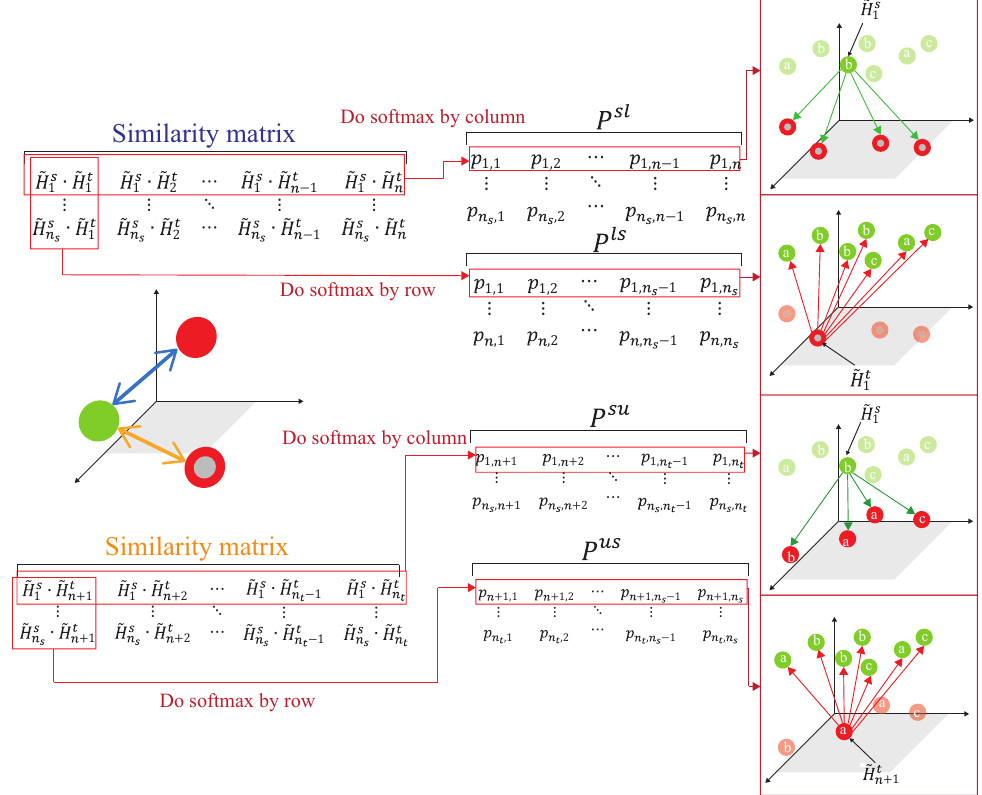
Figure 12. The association between source and target